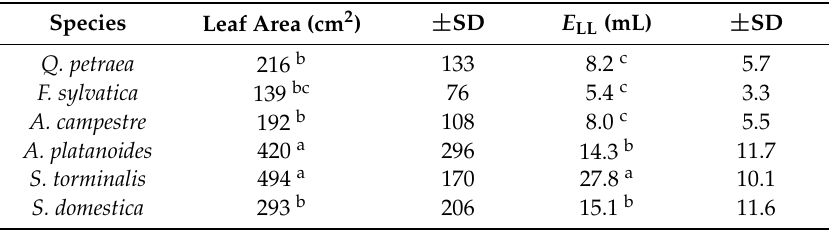
Table 2. Means and standard deviation ( ± SD) of leaf area and daily rates of leaf-level transpiration ( E LL ) at the beginning of the experiment. Various letters indicate significant differences between species ( p < 0.05), n = 18 per tree